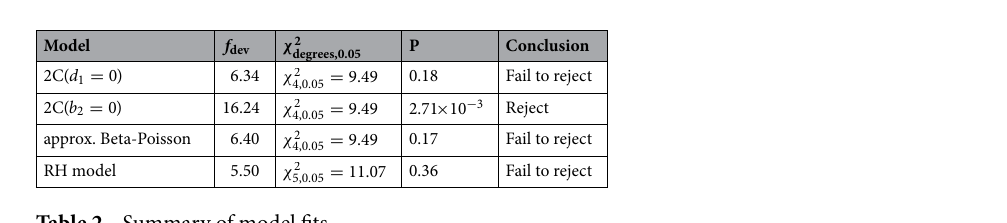
Table 2. Summary of model